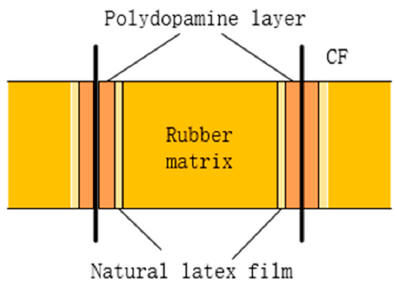
Figure 2. The adhesion interface between the CF and rubber matrix.